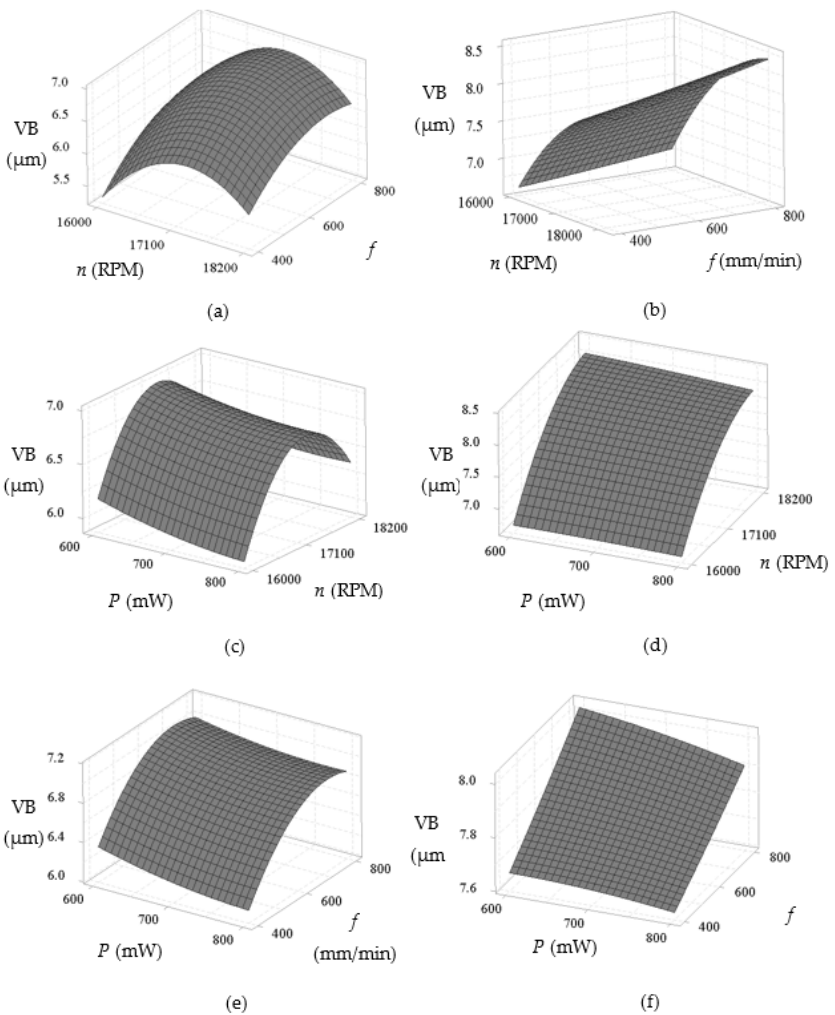
Figure 6. 3D response surface plots of flank wear (VB) in terms of spindle speed—feed rate for: ( a ) Water ‐ soluble sago starch cutting fluid and ( b ) conventional cutting fluid, power—spindle speed for: ( c ) Water ‐ soluble sago starch cutting fluid and ( d ) conventional cutting fluid, and power—feed rate for: ( e ) Water ‐ soluble sago starch cutting fluid and ( f ) conventional cutting fluid.